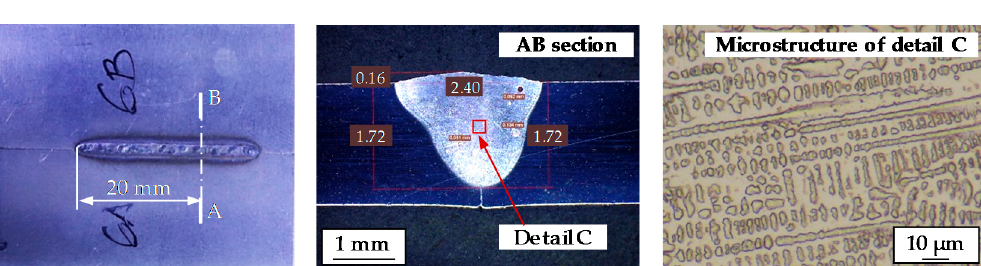
Figure 5. Upper view ( left ), cross section ( center ) and detail of the microstructure ( right ) of the Test 6. Table 3. Process parameters for the different tests.